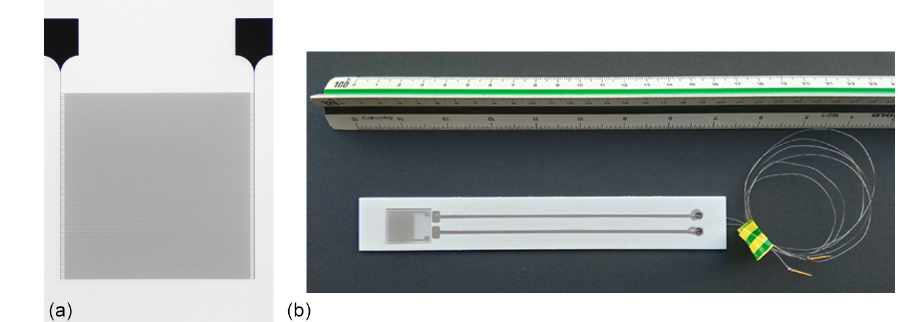
Figure 3. (a) The 200nm thin film platinum comb structure on sapphire substrate. (b) Measurement set-up with conductive tracks for installation in the furnace (Farina, 2021).